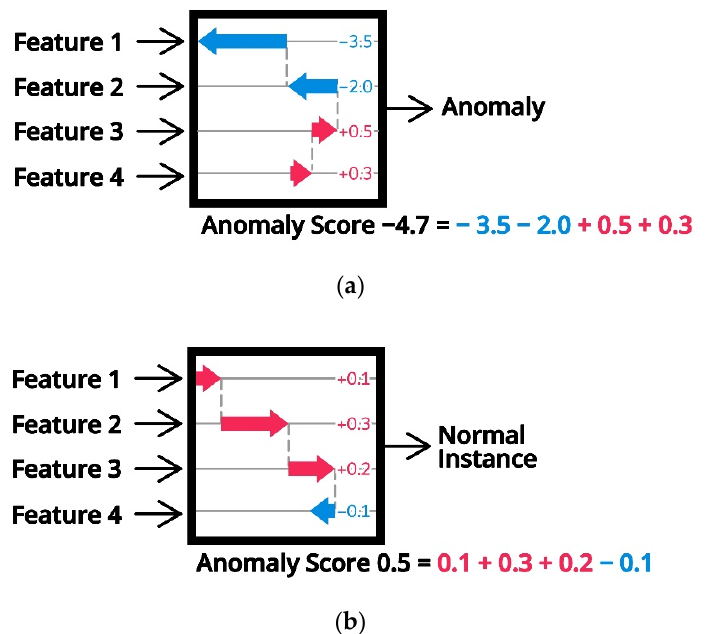
Figure 5. SHAP decomposition between anomalous instance ( a ) and normal instance ( b ).